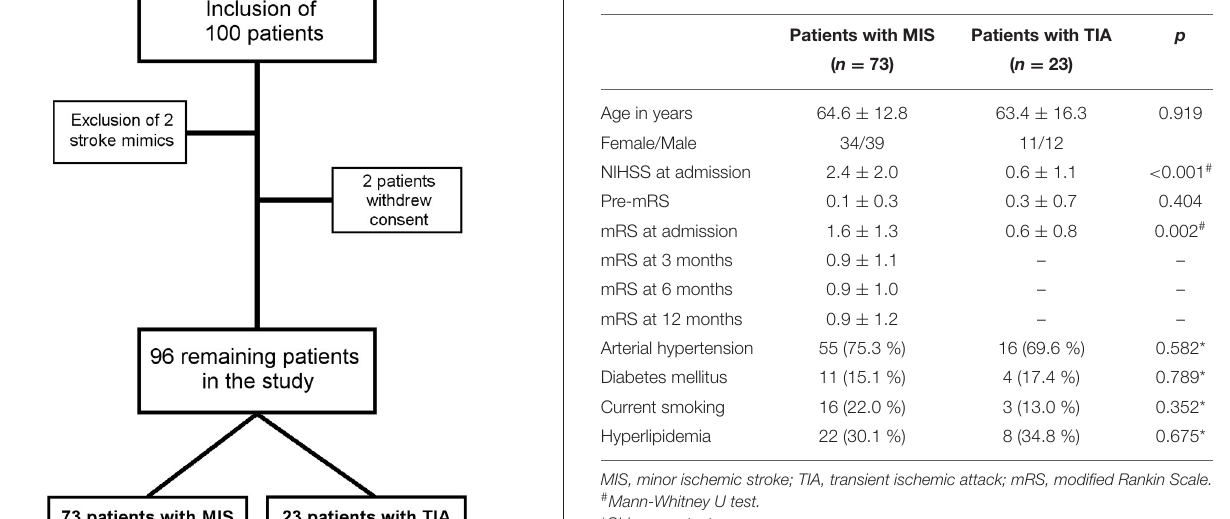
TABLE 1 | Baseline demographic and clinical data of patients with transient ischemic attack and minor ischemic stroke.